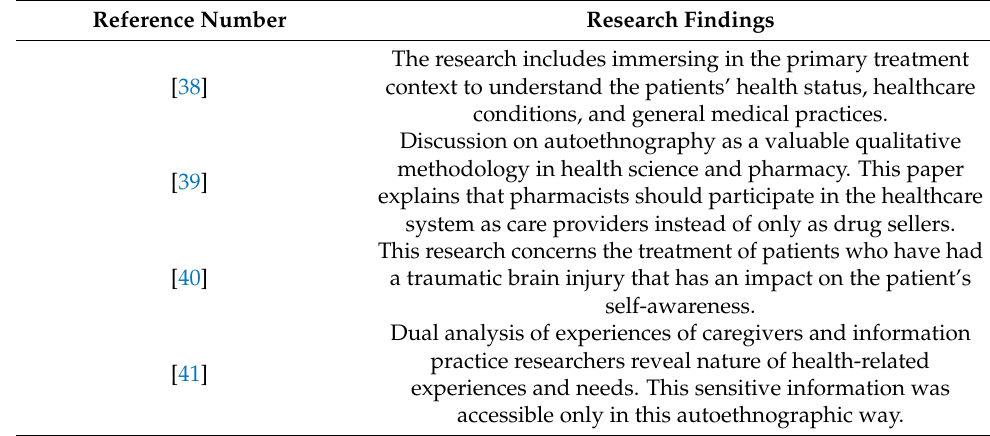
Table 3. Autoethnography research publications on healthcare problems.